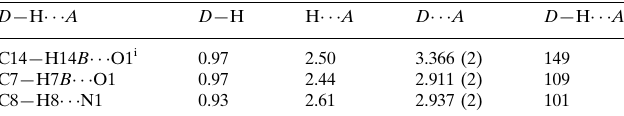
Hydrogen-bond geometry (A˚ , (cid:3)